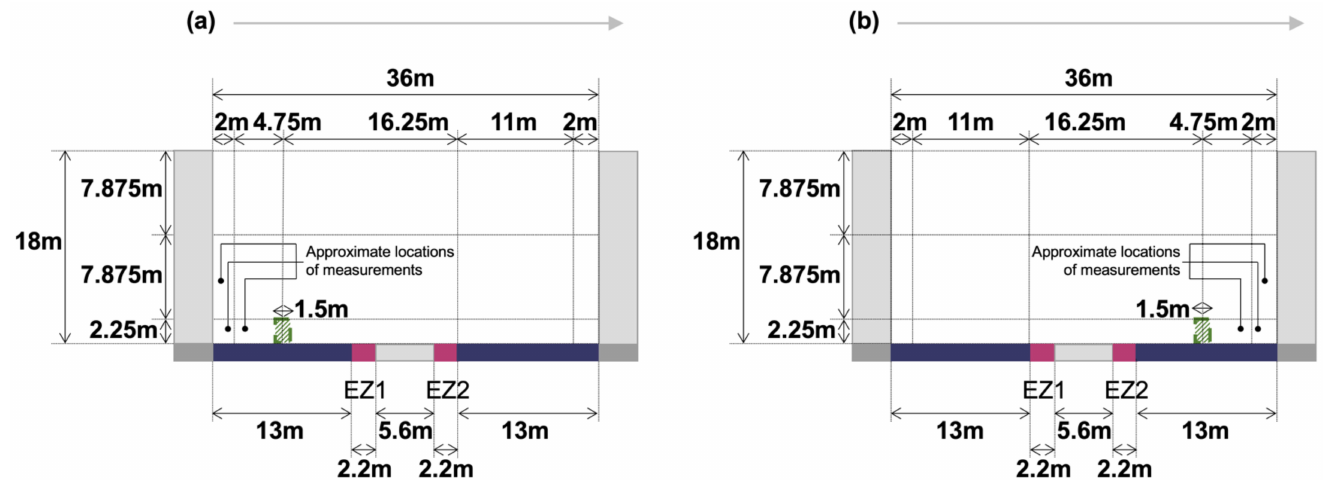
Figure 7. Street section dimensions and model grids adopted in our emulation of a wind tunnel study exploring the impacts of roadside barriers in a street canyon [49] when the barrier is positioned ( a ) upwind or ( b ) downwind with respect to the wind direction aloft; also illustrated are emission zones, EZ1 and EZ2, and the approximate locations of the